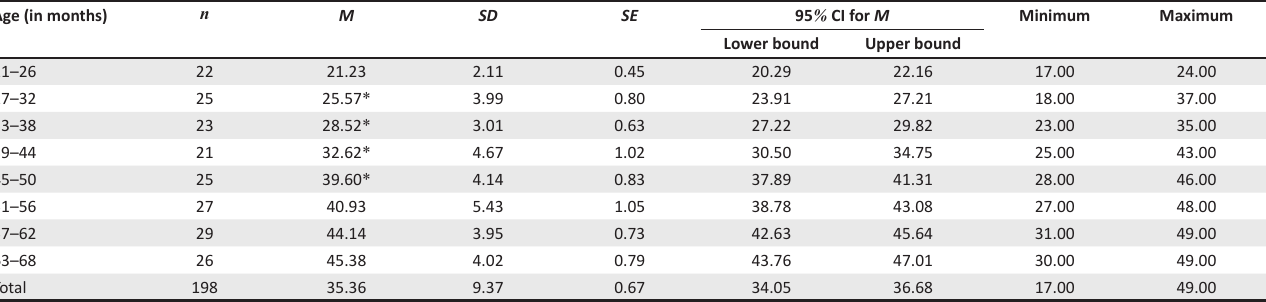
TABLE 6: Fine motor Mullen Scales of Early Learning raw scores, standard deviations, confidence intervals and the range of scores for each age group. Age (in months) n M SD SE 95 % CI for M